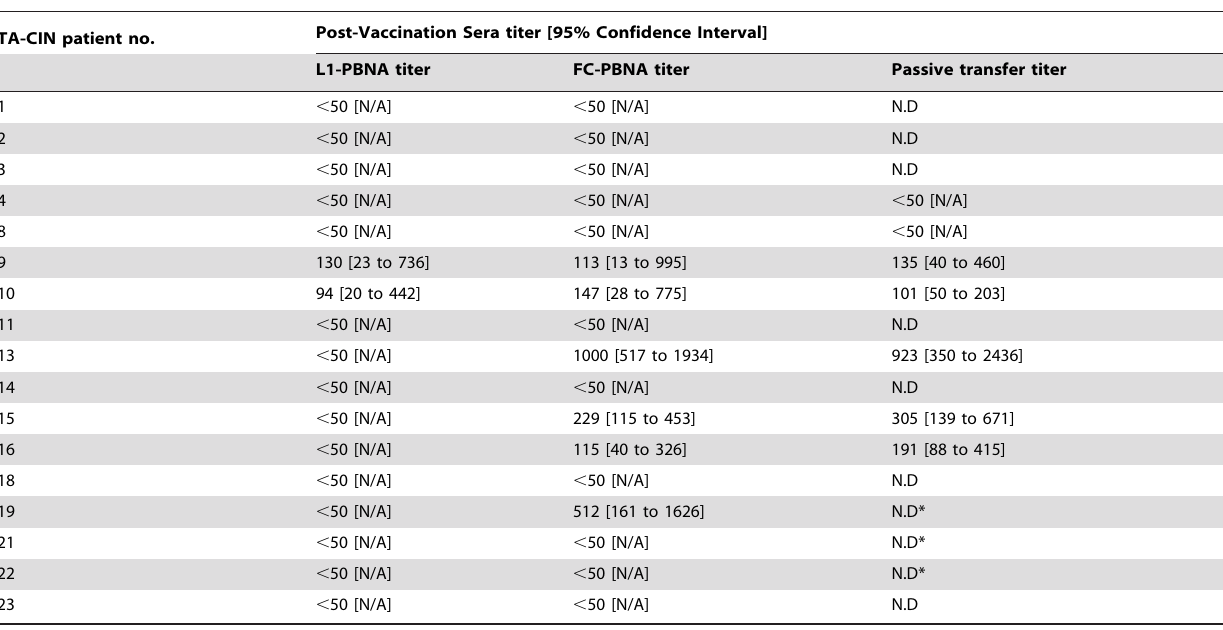
Table 2. Assessment of sera titers of patients vaccinated with TA-CIN using the L1-PBNA, FC-PBNA and titrated passive transfer assay.